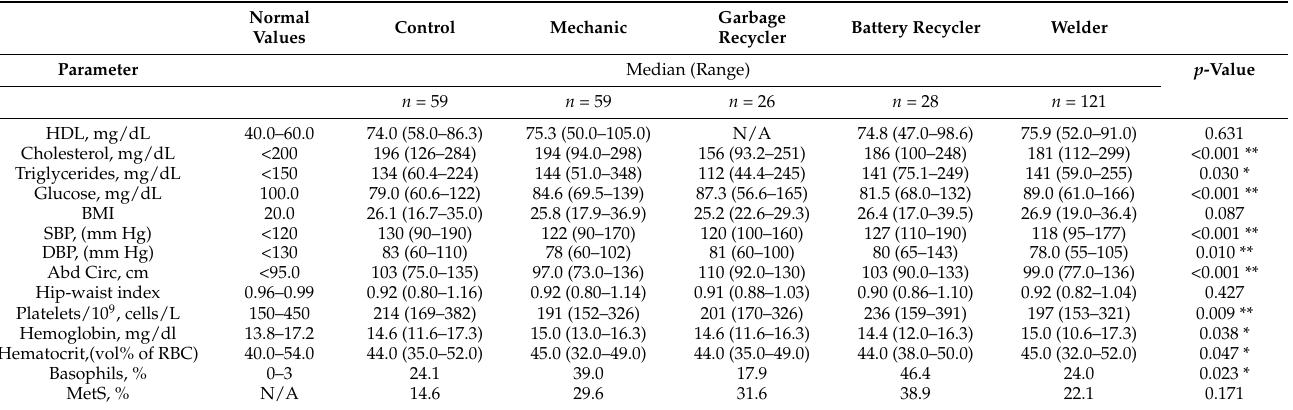
Table 2. Laboratory and anthropometric results in subjects from Cartagena, Colombia, stratified by type of